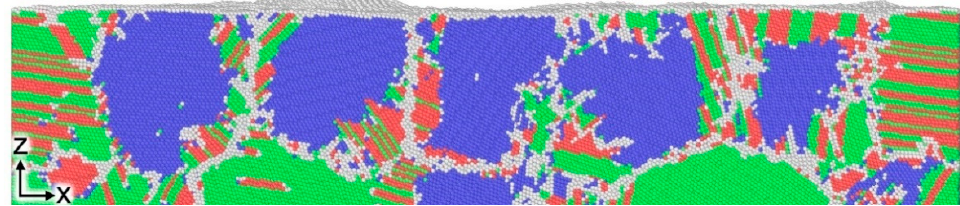
Figure 11. Cross-section of a small-grained layer by the XZ plane at the strain 7.00%. Atoms with bcc, fcc, hcp, and uncertain nearest neighbor symmetry are highlighted in blue, green, red, and light gray, respectively.